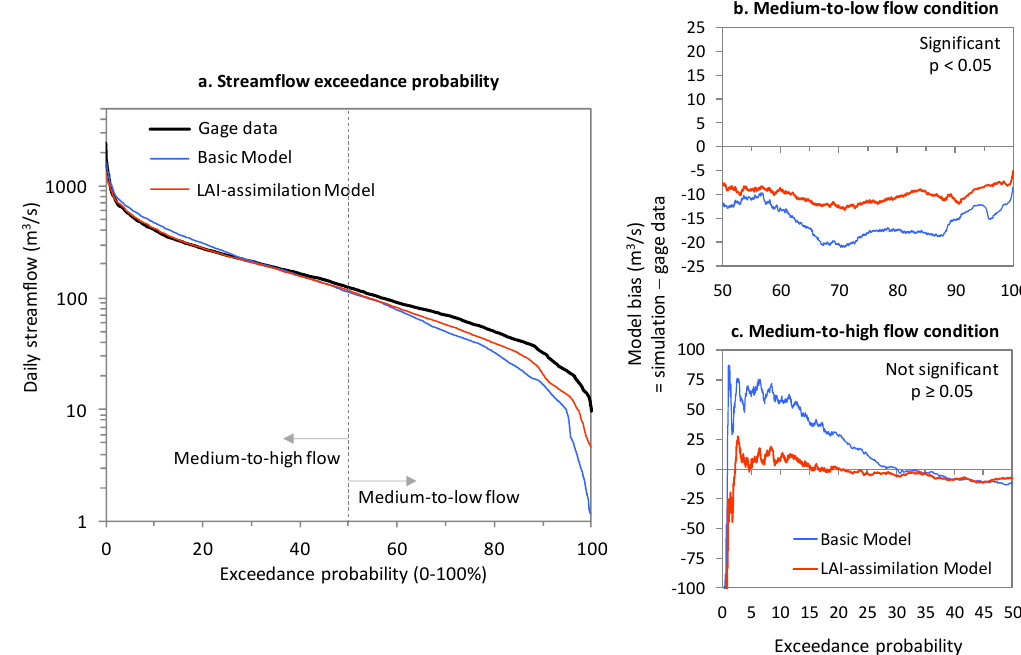
Figure 3. ( a ) Streamflow exceedance probability during 2009–2017 (Y flow being exceeded X percent of all days in the flow record) suggests improved streamflow simulation in the LAI assimilation model, as compared to gage data. ( b , c ) Statistical significance of changes in medium-to-low (streamflow exceedance 50–100%) and medium-to-high flow conditions (streamflow exceedance 0–50%), respectively, based on model bias.